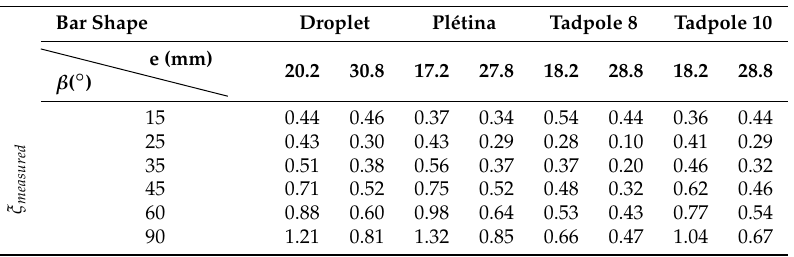
Table A1. Measured head loss coefficient ( ξ measured ) as a function of the bar shapes, the bar spacing (e), and the angle of inclination ( β ).